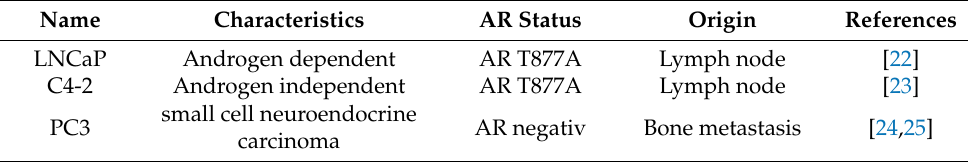
Table 1. Characteristics of the used cell